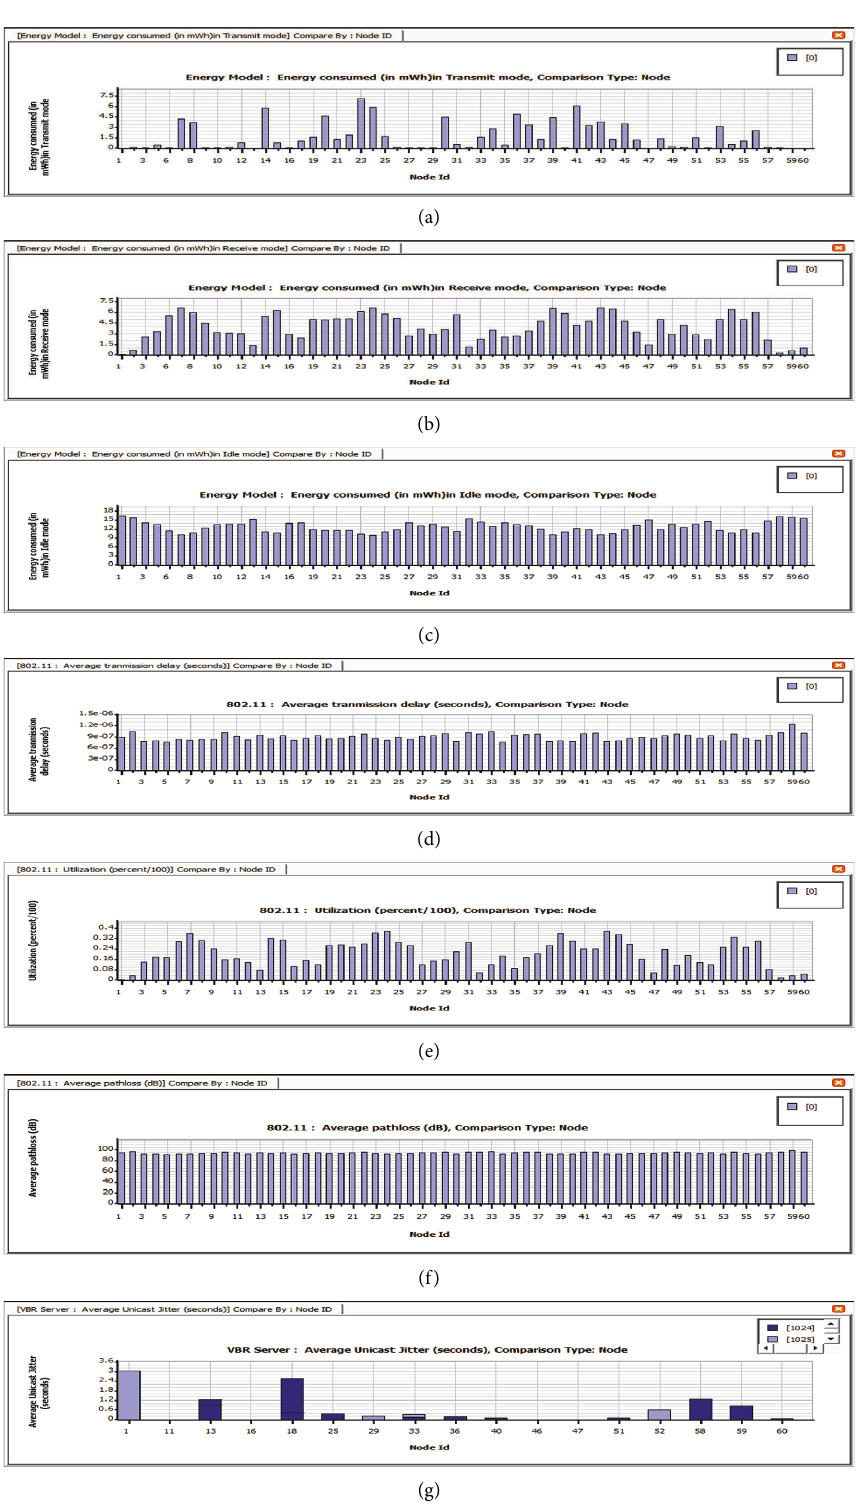
Figure 18: (a) Transmit mode energy consumption of AODV for VBR deployment. (b) Receive mode energy consumption of AODV for VBR deployment. (c) Idle mode energy consumption of AODV for VBR deployment. (d) Average transmission of delay of AODV for VBR deployment. (e) Percentage of utilization of AODV for VBR deployment. (f) Average pathloss of AODV for VBR deployment. (g) Average jitter of AODV for VBR